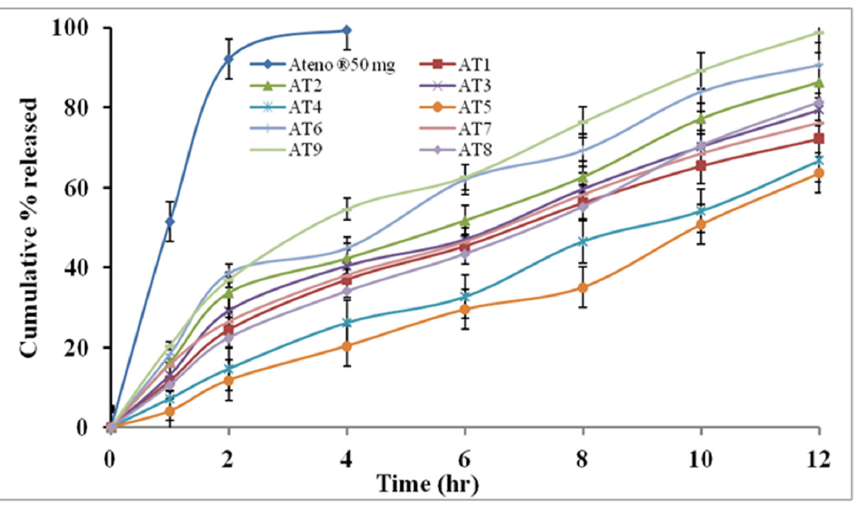
Figure 7. In vitro release profile of AT from the commercial and prepared mono tablets (mean ± SD, n = 3).